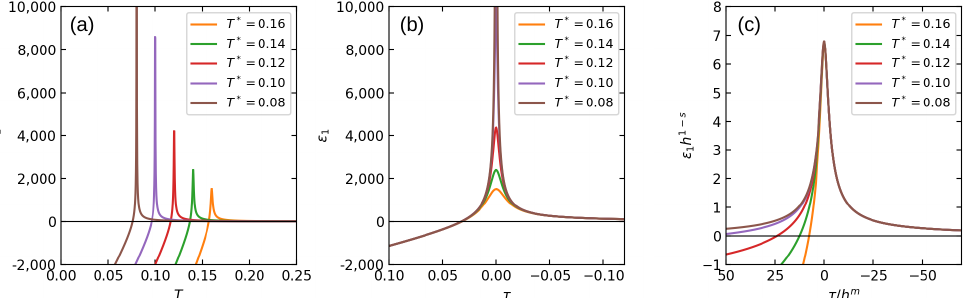
Figure 13. ( a ) The dielectric constant (cid:101) 1 as a function of T for different T ∗ . ( b ) (cid:101) 1 as a function of τ for different T ∗ . ( c ) Scaled dielectric function